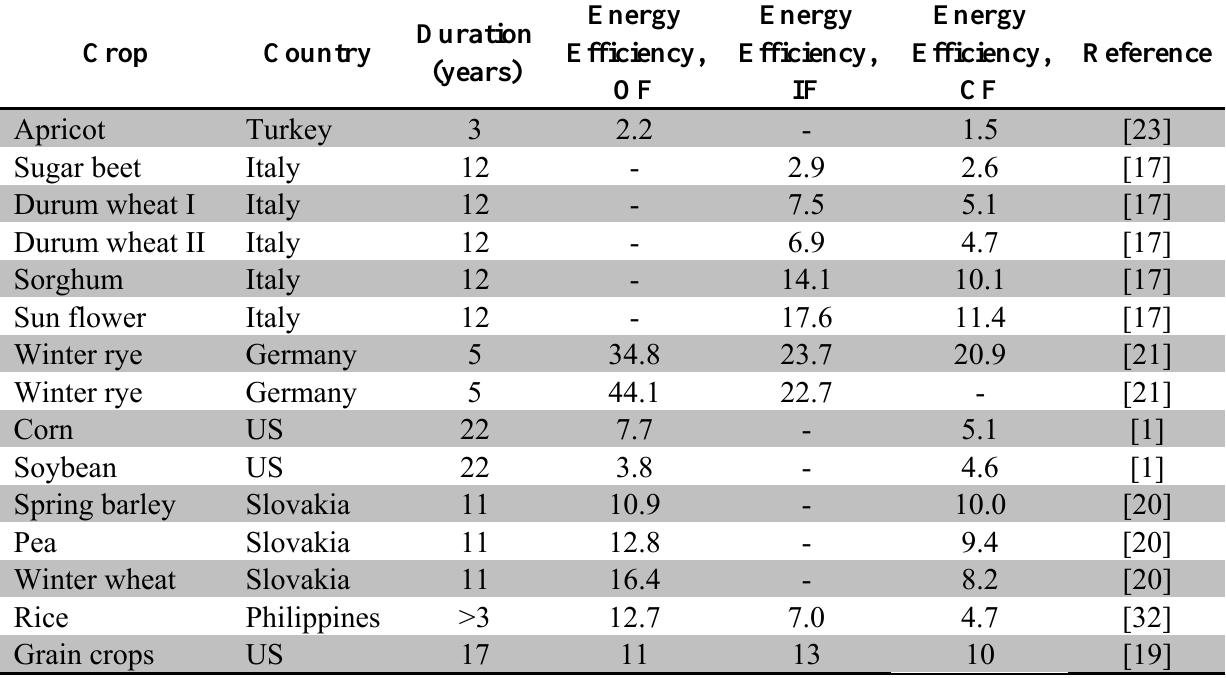
Table 2. Energy efficiency values, calculated as the ratio between the crop production energy output and the energy input, for different species in various cropping systems (e.g., OF, organic farming; IF, integrated farming; CF, conventional